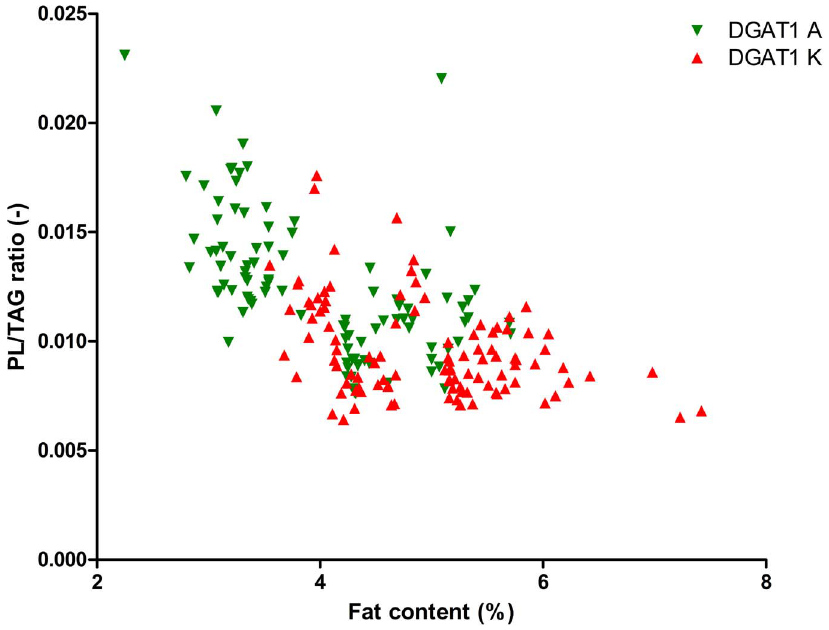
Figure 2. Relationship between fat content (%) and phosphatidylinositol (PI) content (% of total phospholipids (PL)) differentiated by DGAT1 genotype.